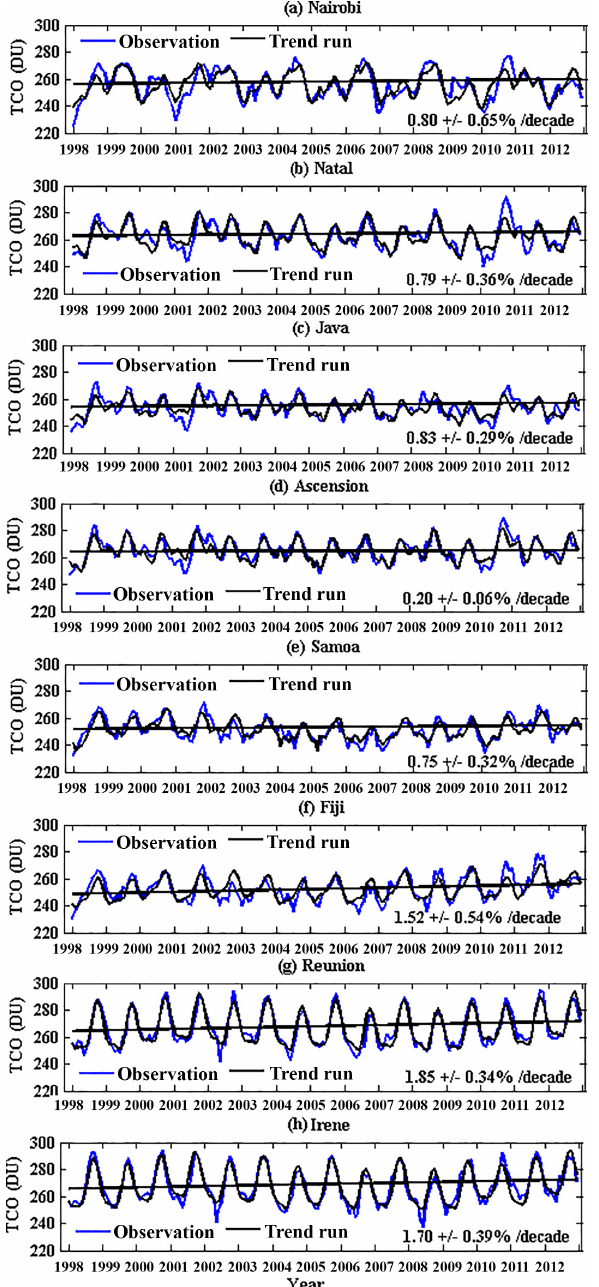
Figure 13. Time evolution of monthly total ozone values (blue) ob- served at each site. The black lines represent the time evolution of the TCO obtained by the Trend-Run model, the blue lines show ob- servation data, and the straight black line illustrates the obtained decadal trend.